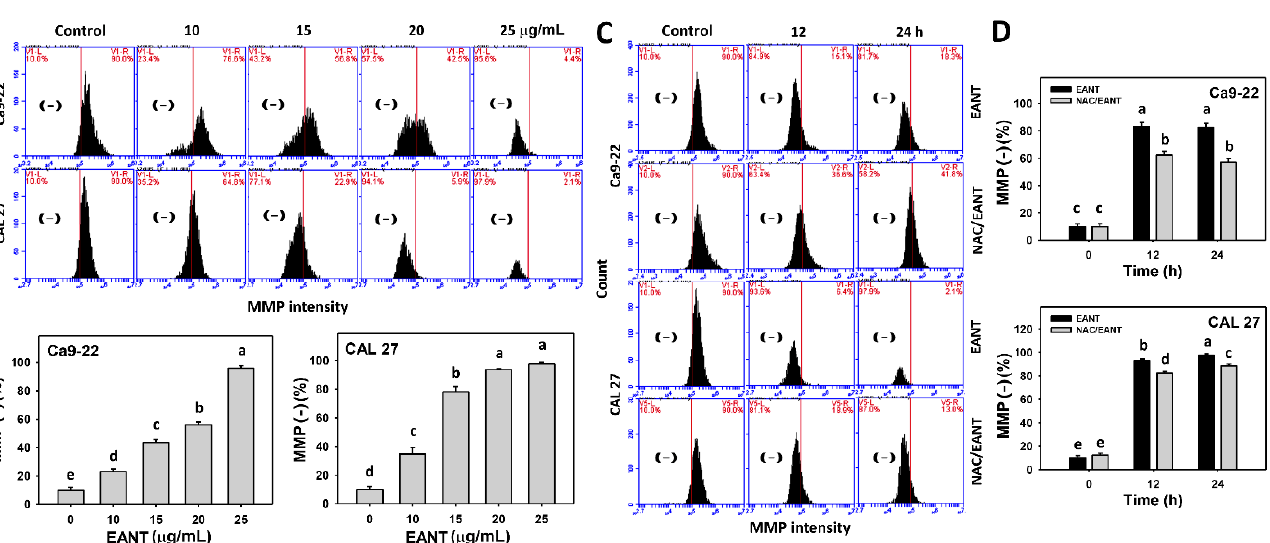
Figure 7. MMP analyses. ( A , B ) MMP patterns and statistical analysis for EANT treated oral cancer cells (CAL 27 and Ca9-22) for 24 h. ( C , D ) NAC (10 mM) pretreatment outcome on MMP patterns and statistical analysis in EANT treatments (0 and 25 μg/mL) for 0, 12, and 24 h. Data (mean ± SD, n = 3) showing different letters on top differ significantly for multiple comparisons ( p < 0.05).